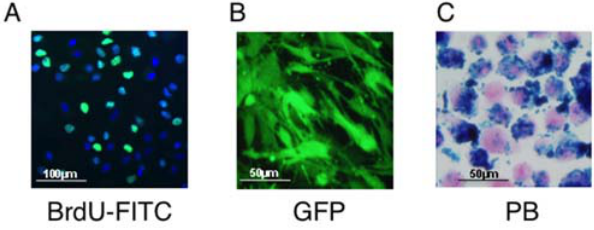
Figure 1. Labeling of human bone marrow stromal cells (BMSCs) with BrdU, GFP and Fe-Pro. Representative fluorescent microscopy images of BrdU – labeled hBMSCs stained with anti BrdU- FITC antibody (A), GFP expressing hBMSCs after lentiviral transduction (B) and Prussian Blue (PB) stained Fe-Pro labeled hBMSCs (C), magnification 40X.